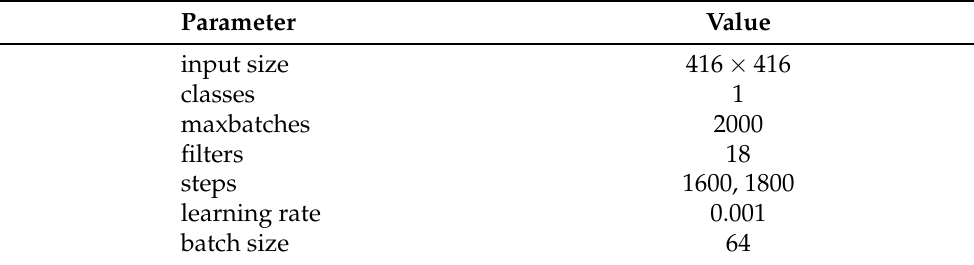
Table 1. Parameters of YOLOv4 fox detection